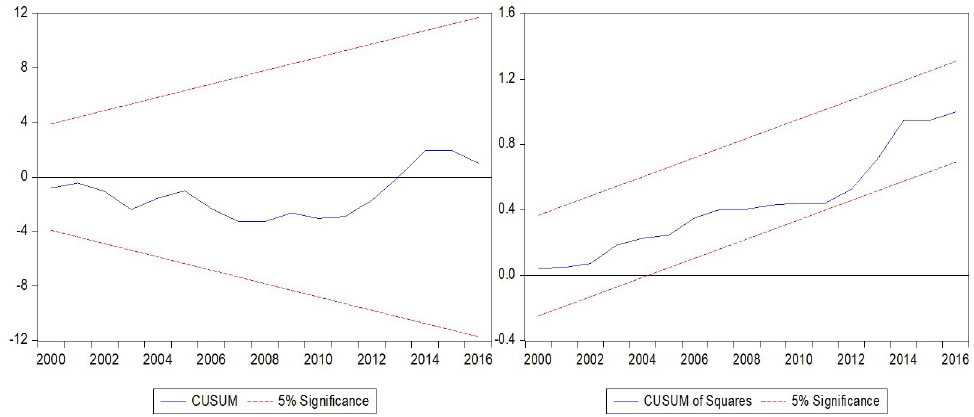
Fig 2. Model (5) CUSUM and CUSUM of squares test. CUSUM and CUSUM of Squares are tests for model stability. At 5 percent significance level, the lines stay within the critical bounds, indicating long-run model stability.